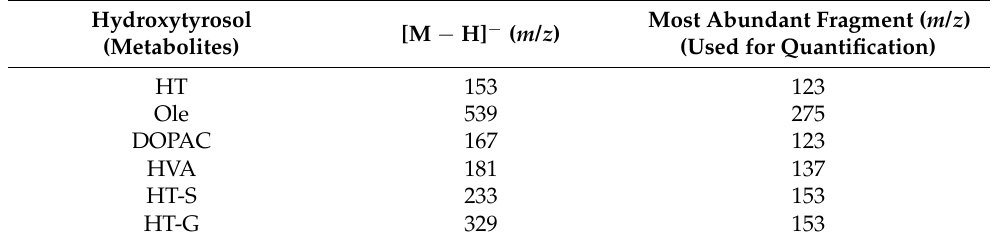
Table 2. Mass transitions of hydroxytyrosol and its metabolites. HT: hydroxytyrosol, Ole: oleuropein, DOPAC: 3,4-dihydroxyphenylacetic acid, HVA: homovanillic acid, HT-S: hydroxytyrosol sulphates, HT-G: hydroxytyrosol glucuronides.